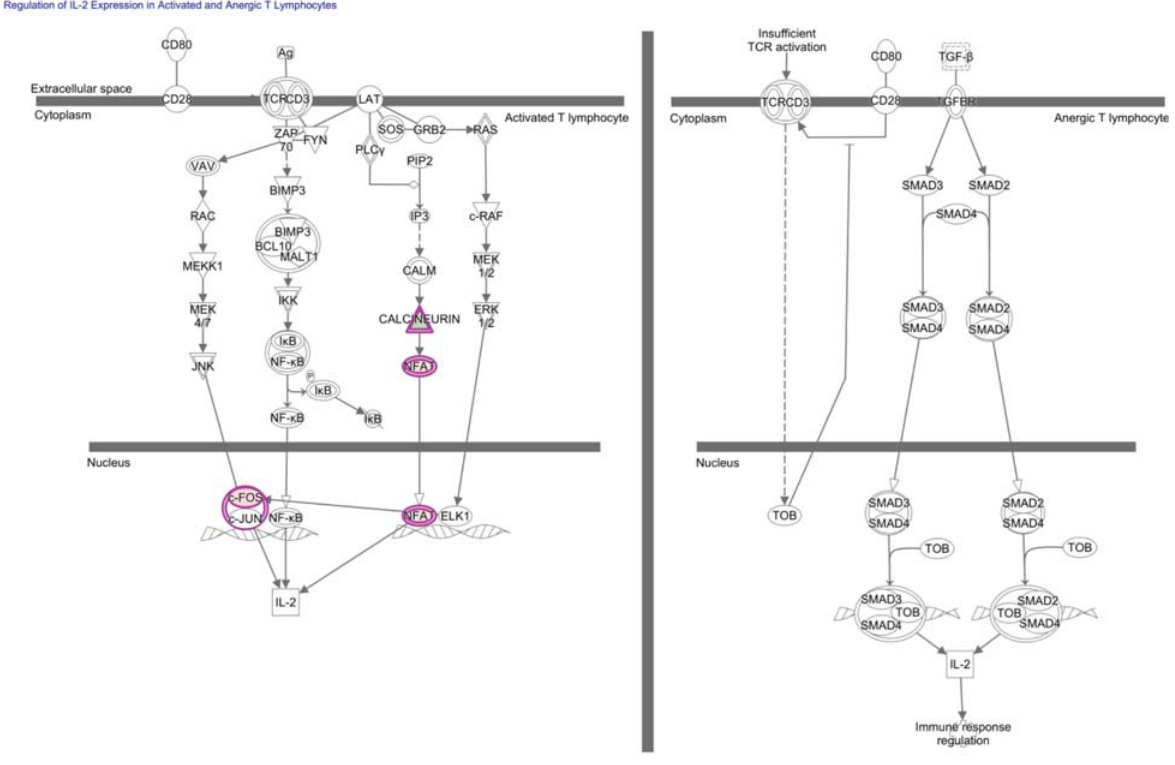
Figure 3. Activated and anergic T cells differentially relay extracellular signals to the IL-2 locus. Regulation of IL-2 Expression in Activated and Anergic T Lymphocytes is a canonical pathway enriched for molecules corresponding to differentially-expressed genes of tumor-specific CD8+ T cells from the tumor relative to the periphery ( p -value = 4.9E-2, right-tailed Fisher Exact Test). These molecules are outlined in purple with red fill representing overexpression and green fill representing decreased expression in T cells from the tumor relative to the periphery, and color intensity corresponds to the extent of expression difference. Differentially-expressed genes and corresponding fold-changes have been previously published and were reanalyzed through the use of QIAGEN’s Ingenuity ® Pathway Analysis (IPA ® , QIAGEN, Redwood City, www.qiagen.com/ingenuity) [35]. Both direct and indirect relationships were assessed in the Ingenuity knowledge base reference set with a confidence threshold of previous experimental observation in T